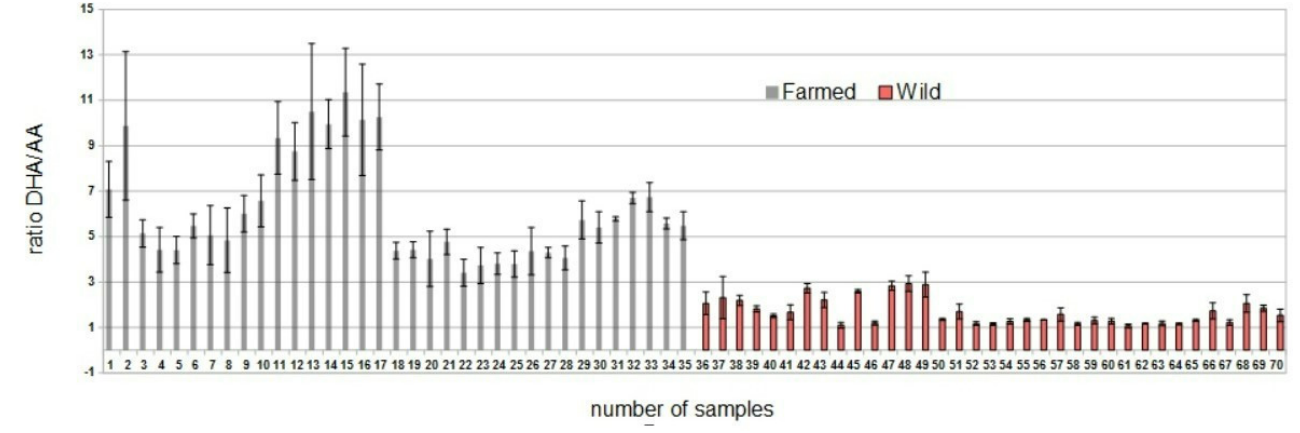
Figure 2. Fatty acids ratio values in sea bass samples analysed under the same conditions. Each value is an average of triplicate analyses (with SD).